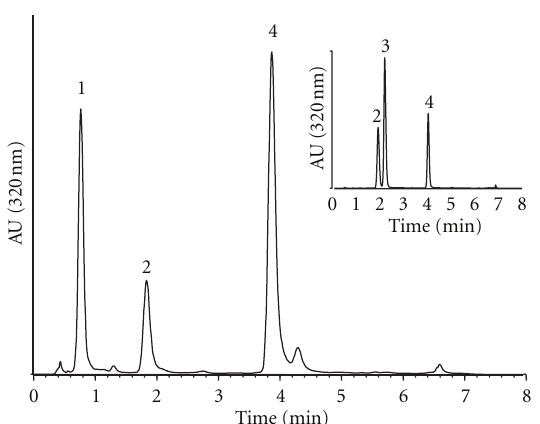
Figure 3: HPLC profile of chicory leaves with the “short program,” using the “novel” method. Peak identifications: (1) caftaric acid, (2), chlorogenic acid, (3) ca ff eic acid (insert), and (4) chicoric acid. Chromatogram was recorded at